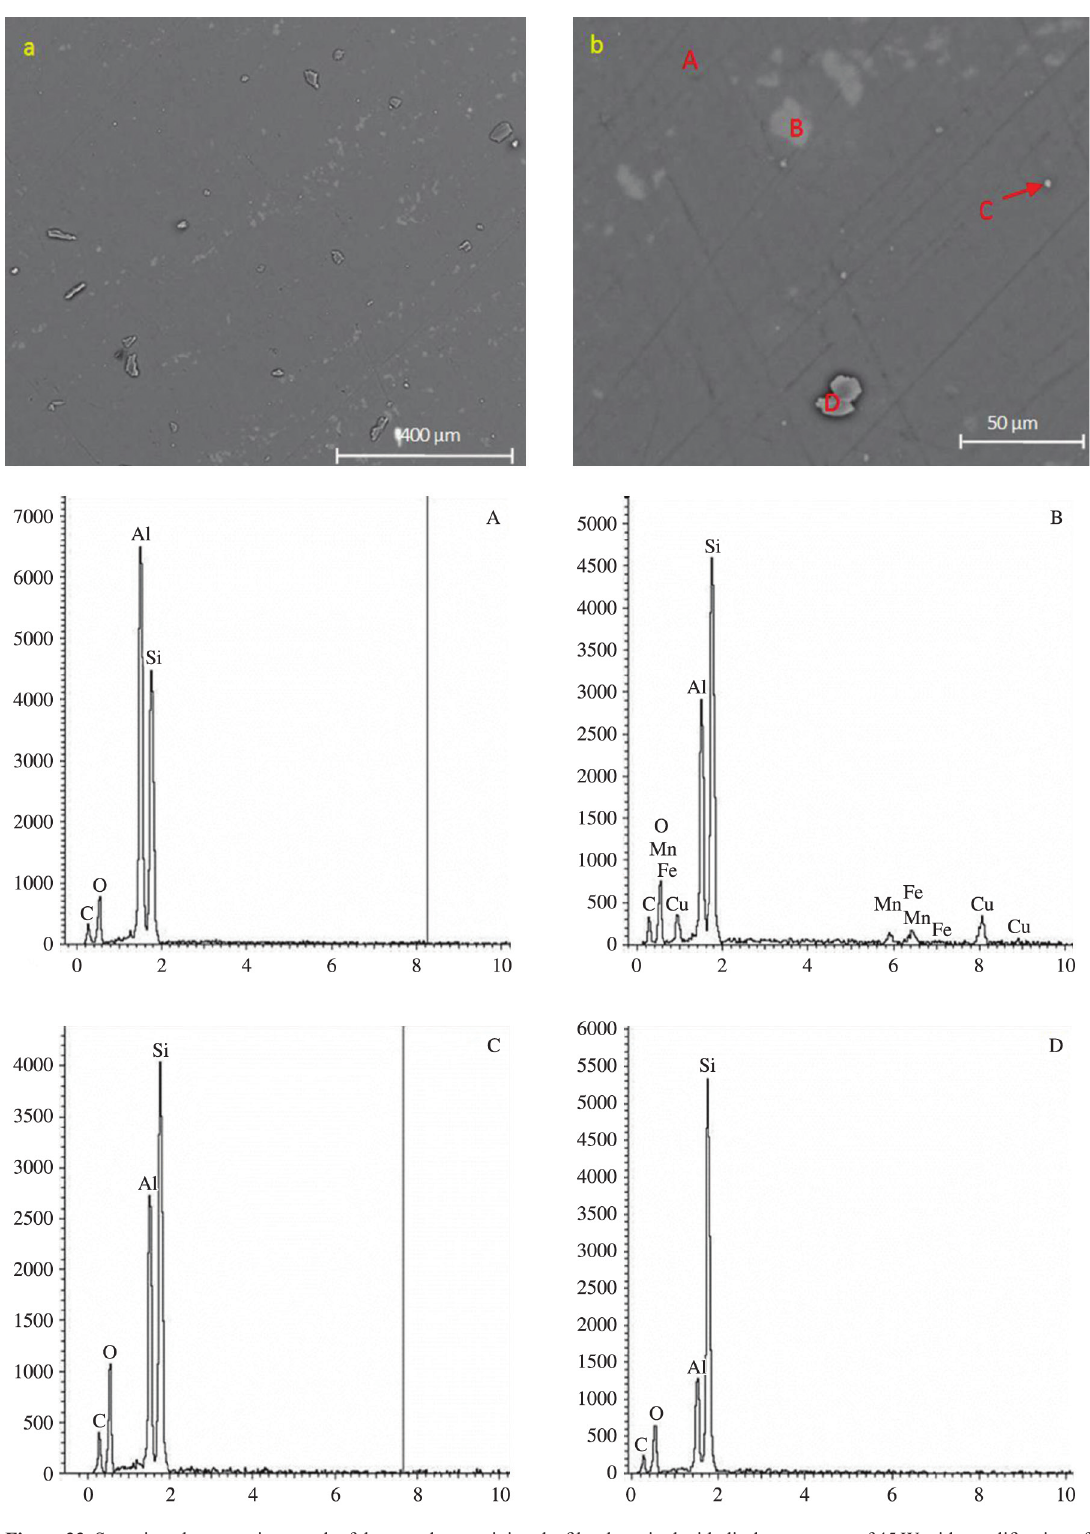
Figure 23. Scanning electron micrograph of the sample containing the film deposited with discharge power of 45 W with amplification of (a) 250 times and (b) 1500 times. A, B, C and D are energy dispersive spectra of the regions A, B, C and D of the micrograph shown in